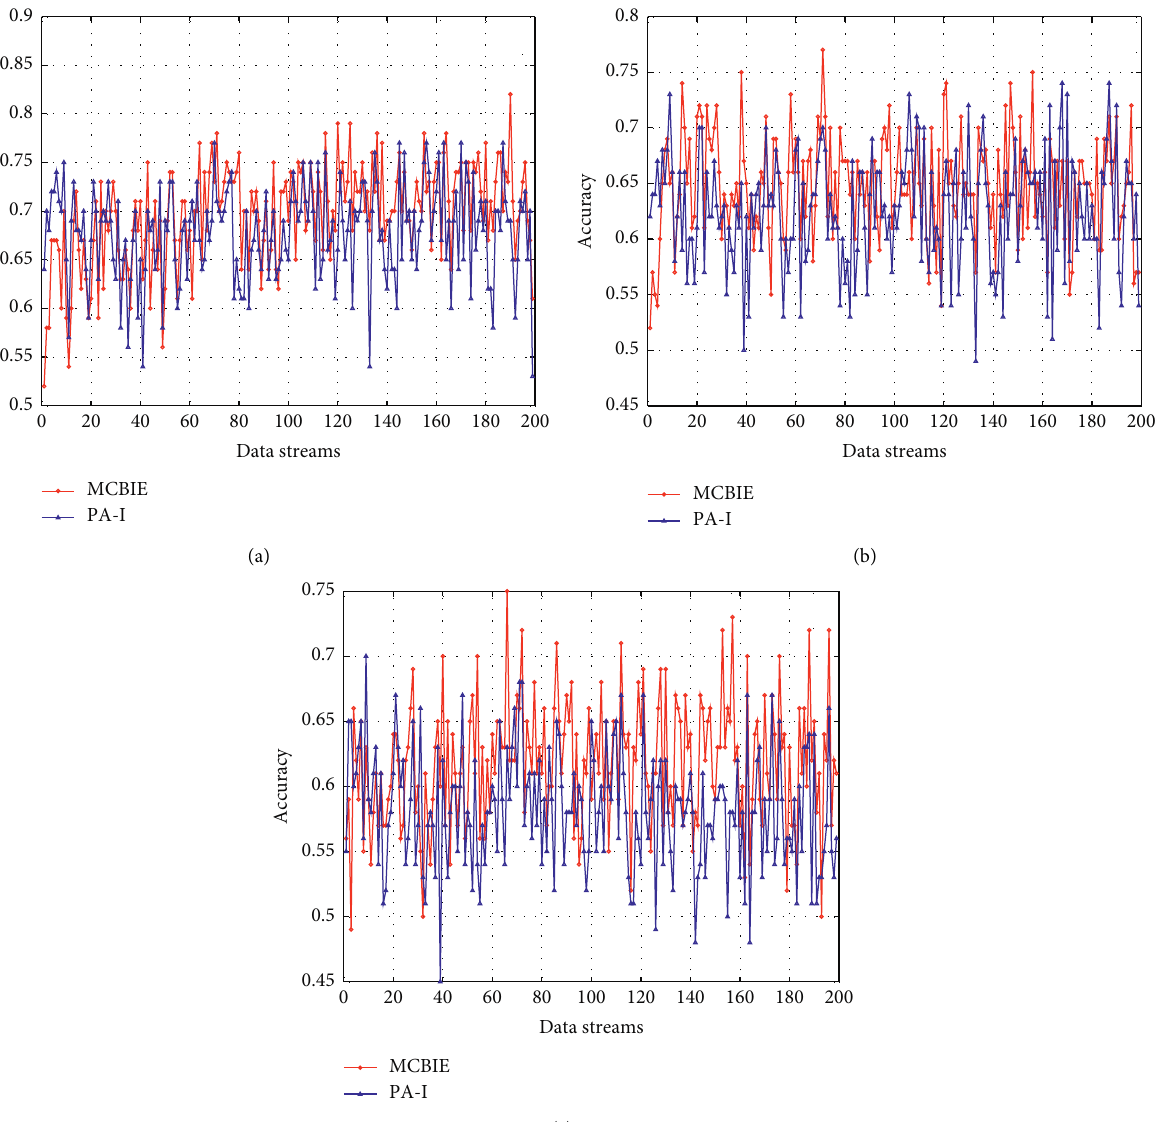
Figure 7: The accuracy curve for the two best methods over Hyperplane data streams. (a) Hyperplane with 20% noise. (b) Hyperplane with 25% noise. (c) Hyperplane with 30%